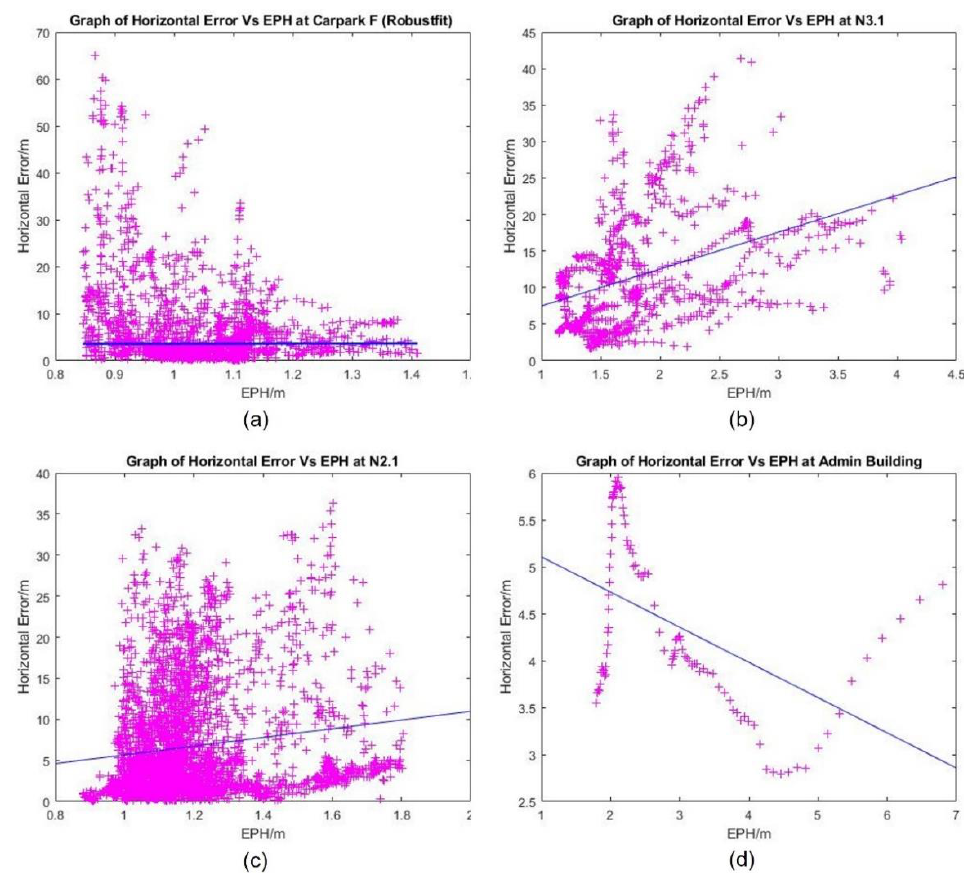
Figure 11. Graph of Measured Horizontal Error vs. EPH with Least Square Line in Blue at the 4 Locations: (a) Car Park F, (b) N3.1, (c) N2.1 and (d) the Admin Building.